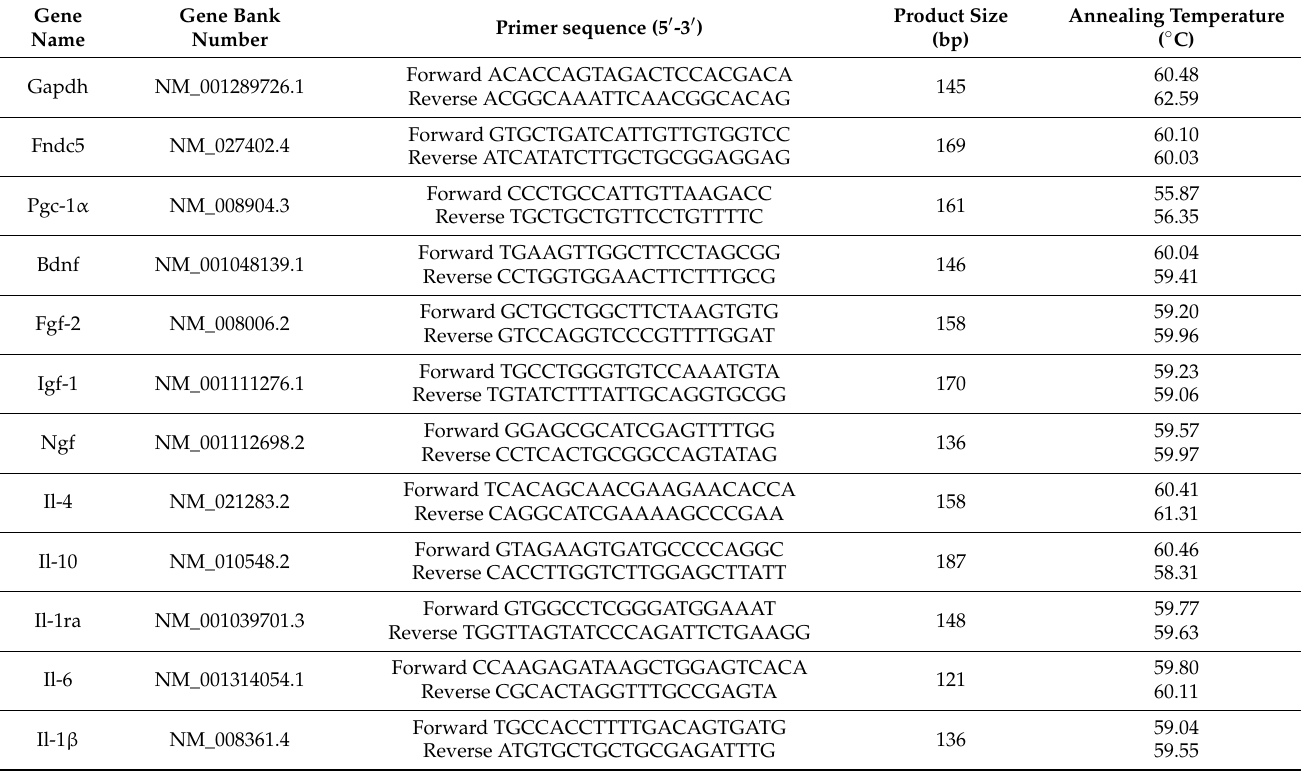
Table 3. Primer sequences used for quantitative real-time